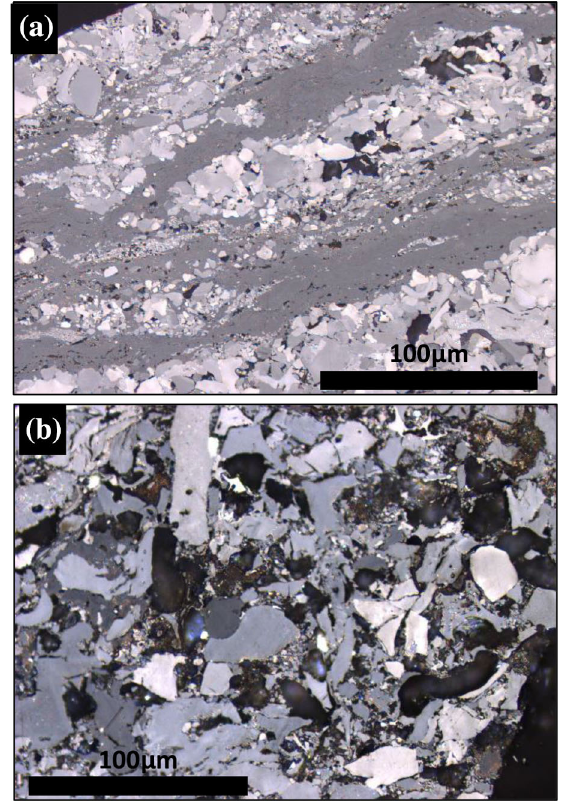
Fig. 10 a Alternating layers of inertodetrinite and vitrinite; b iner- todetrinite, observed in the inertinite-rich sample. 9 500 magnifica- tion, reflected light with oil immersion. Scale is